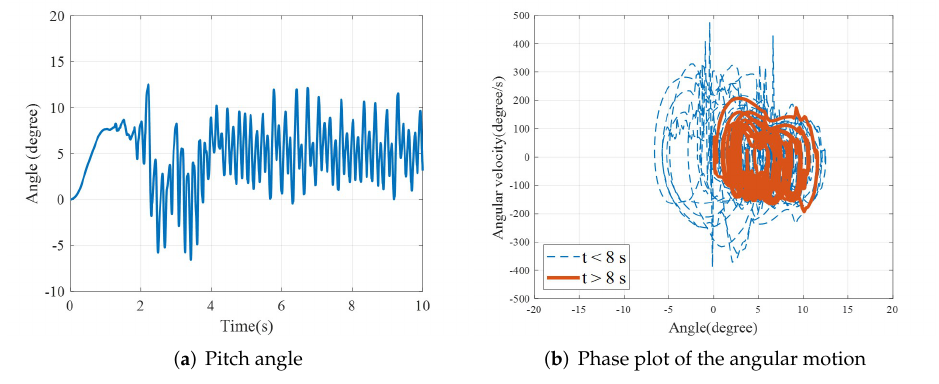
Figure 8. Angular motion of the upper body when the target speed is 4.5 m/s.